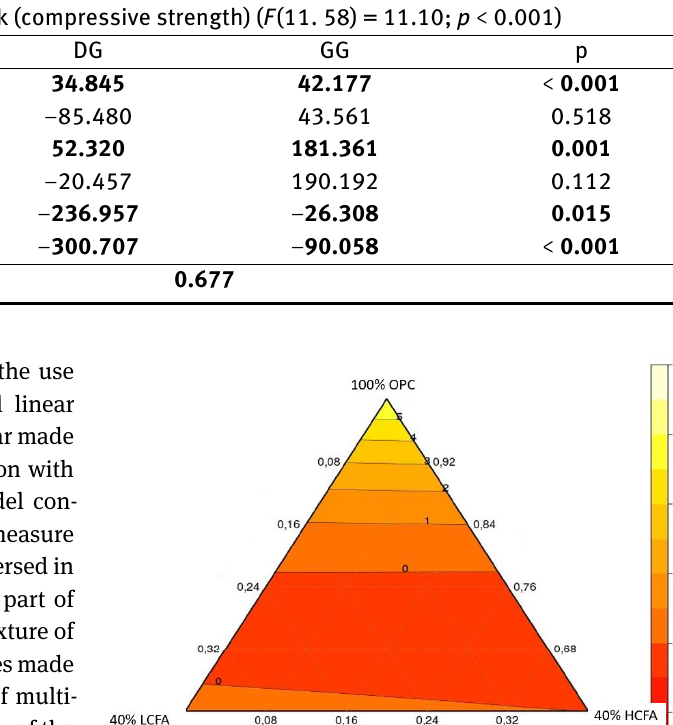
Table 4: Relations between the mortar binder composition and strength - multiple linear regression models. Effect